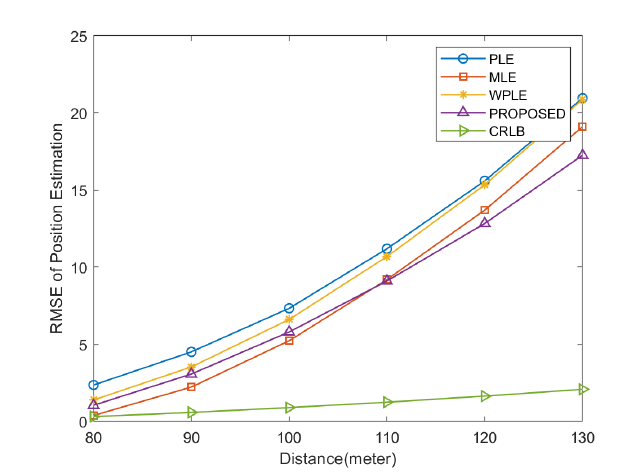
Figure 13. RMSE of position estimation versus target distance.